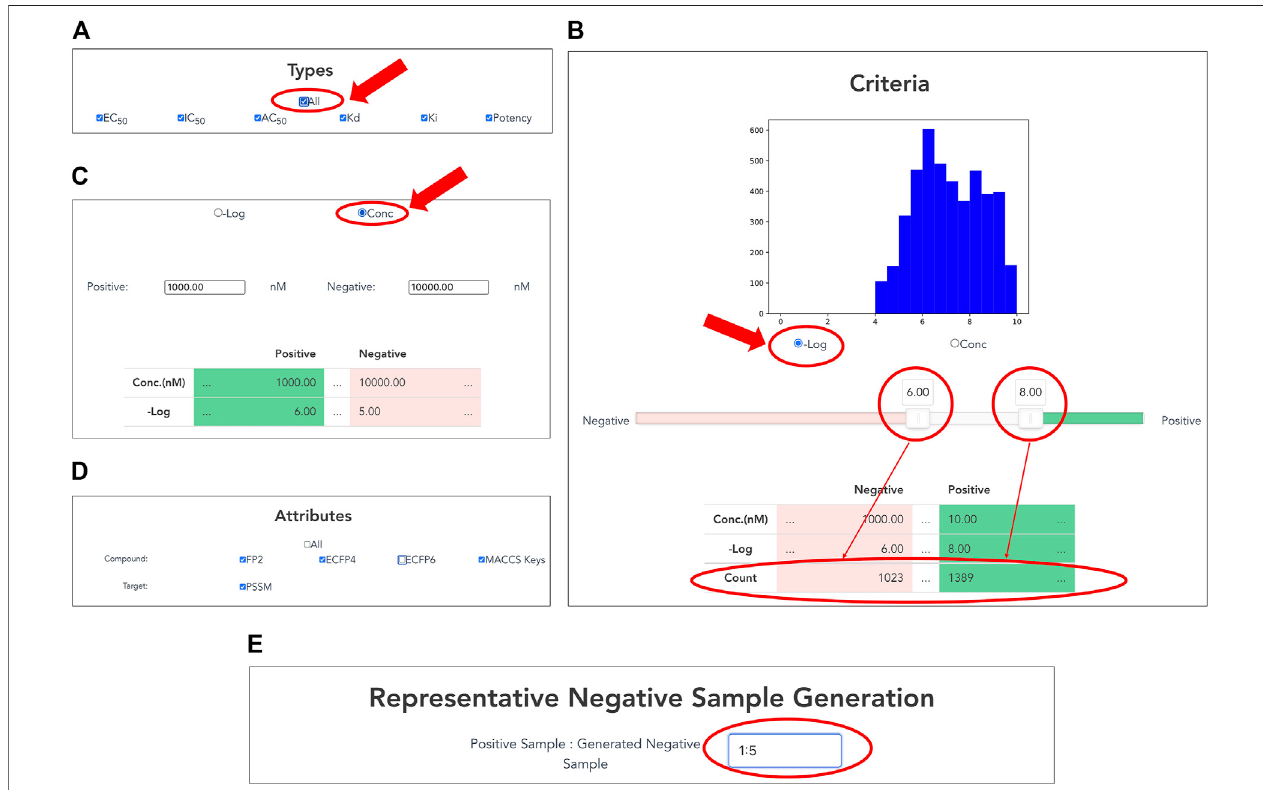
FIGURE 3 | Customizing compound – protein interaction datasets. Activity data are fi ltered by activity types and a range of activity values. (A) Selection of activity types from EC 50 , IC 50 , AC 50 , Kd, Ki, and potency. (B) Setting thresholds for negative logarithms of activity values in nM units. Users can easily set thresholdsfor positive andnegativedatausingaslidebarifselecting “ − Log ” ofradiobutton.Thegraphicaldisplayofthehistogramoftheactivityvaluesandthecounterofthenumberofactivity values help the user to set the appropriate threshold values. (C) Users can directly input concentration thresholds for activity values (nM) of positive and negative data if checking “ Conc ” of radio button. (D) Selection of compound and protein attributes for output. Users can select compound attributes from ECFP4, ECFP6, FP2, andMACCSkeys(CanonicalSMILESbydefault),aswellasproteinattributesasPSSM(proteinsequencebydefault). (E) Generationofrepresentativenegativesamples. Users can customize the amount of negative data for output. This function allows users to select the amount of negative sample generated from 1, 3, and 5 times the amount of the positive